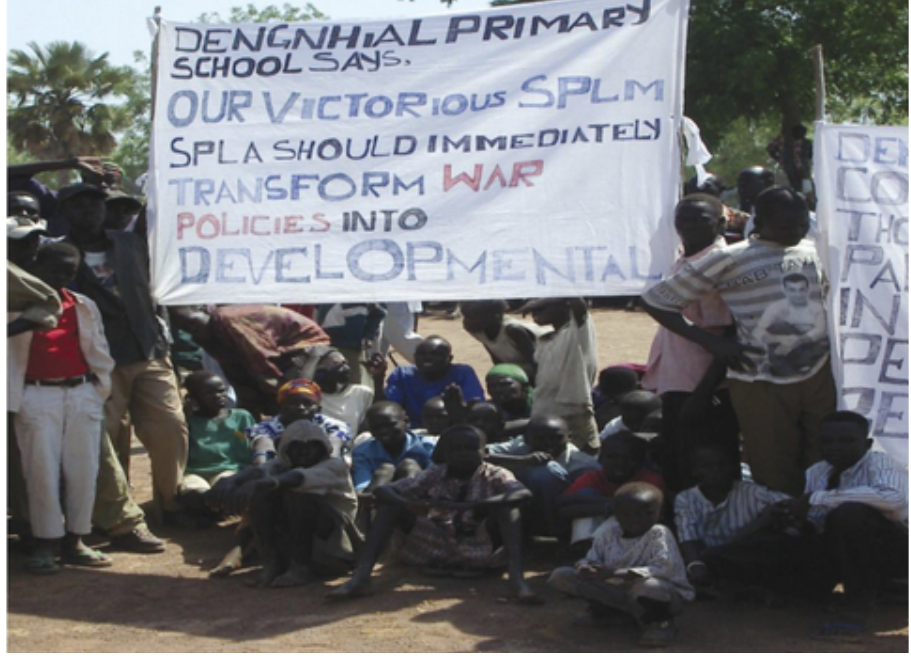
Figure 4. Calls for the transformation of war policies into development